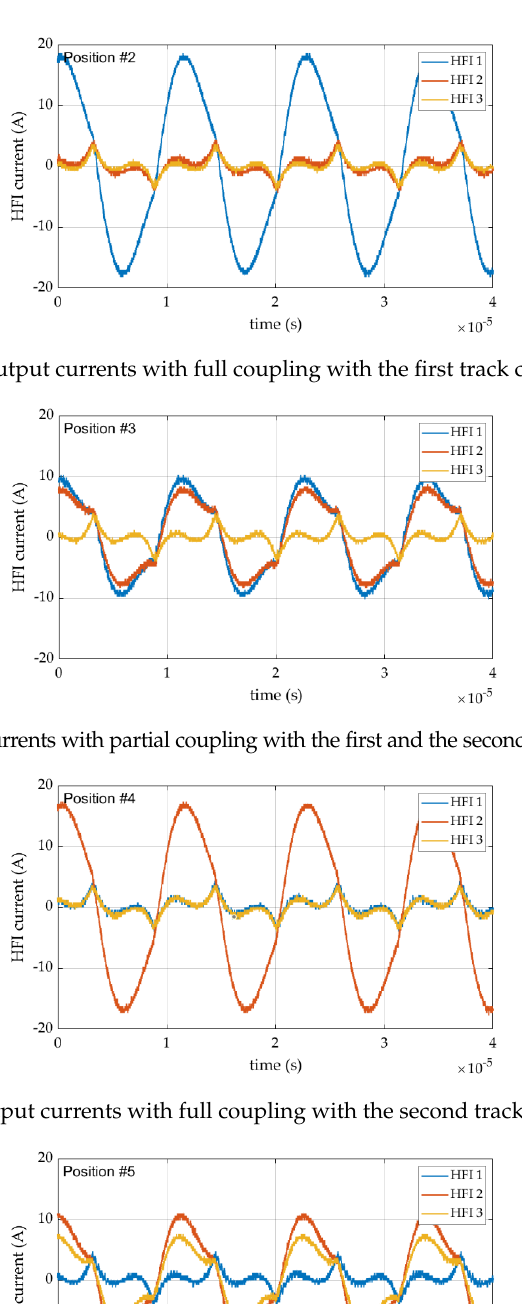
Figure 22. HFIs output currents with full coupling with the third track coil (Position #6). Figure 23. HFIs output currents with partial coupling with the third track coil (Position #7). The profile of the power transferred to the electronic load while the pickup moves along the track is plotted in Figure 24. The positions considered in the previous discussion are highlighted by red arrows. The figure shows that the transferred power reaches its maxima when the pickup is aligned with one track coil. When the pickup lays between two track coils the system is less effective in supplying the load and, despite the joint contributions from two track coils, the transferred power falls down to its minima. In any case, the average transferred power from Position#2 to Position#6 fulfills the requirement set in Section 2, being about equal to 3.2 kW.